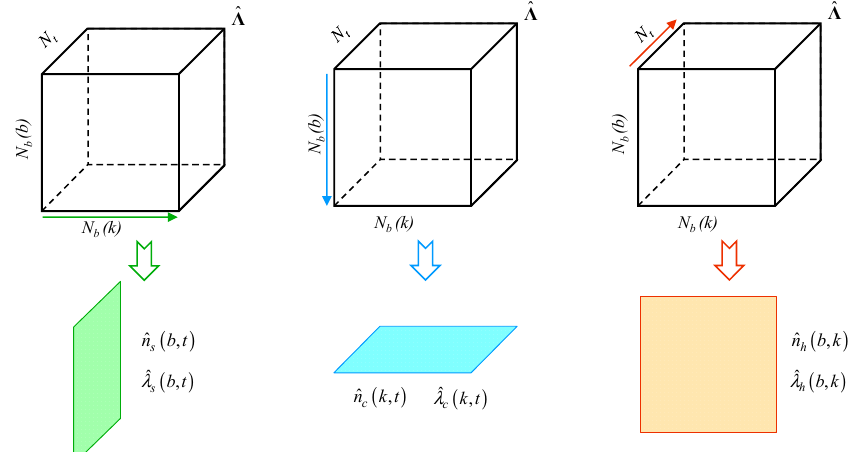
Figure 1. Statistical analysis applied to the N − 1 overload matrix.